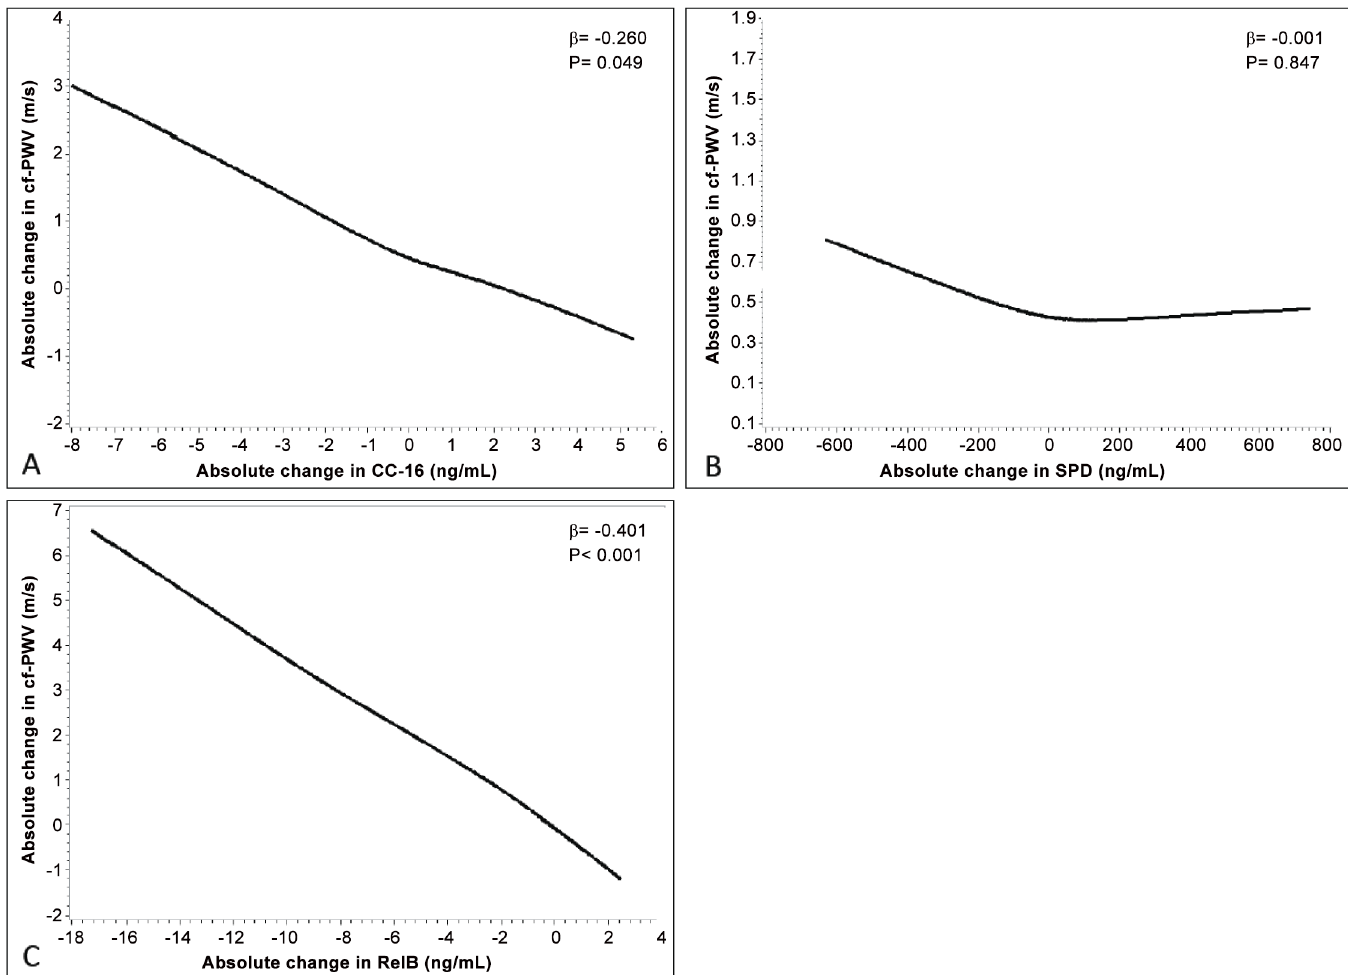
Fig 3. Relationship between the absolute course of change in inflammatory mediator concentrations (ng/mL) over time to that of changes in cf- PWV (m/s). Panel A shows the relationship between the absolute change in CC-16 and cf-PWV over time, panel B shows the relationship between the absolute change in SPD and cf-PWV over time, and panel C shows the relationship between the absolute change in RelB and cf-PWV over time. There was a strong statistically significant negative relationship between the absolute change in CC-16 and cf-PWV as measured over time, as well as between RelB and cf-PWV (p < 0.05). There appeared to be a negative relationship between the absolute change in SPD and cf-PWV over time, although this was not found to be statistically significant. Mixed-effects linear models adjusted for age, sex, forced expiratory volume in 1 second % predicted and days since initial exacerbation were used to estimate these relationships. β values show the resulting change in cf- PWV in m/s with a 1-unit (ng/mL) increase in an inflammatory